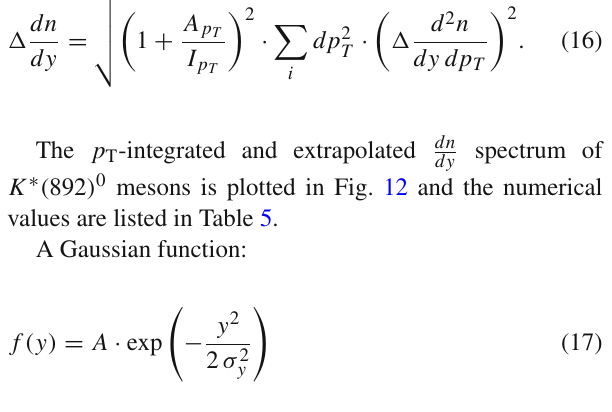
extrapolated dn values were calculated as follows: dy